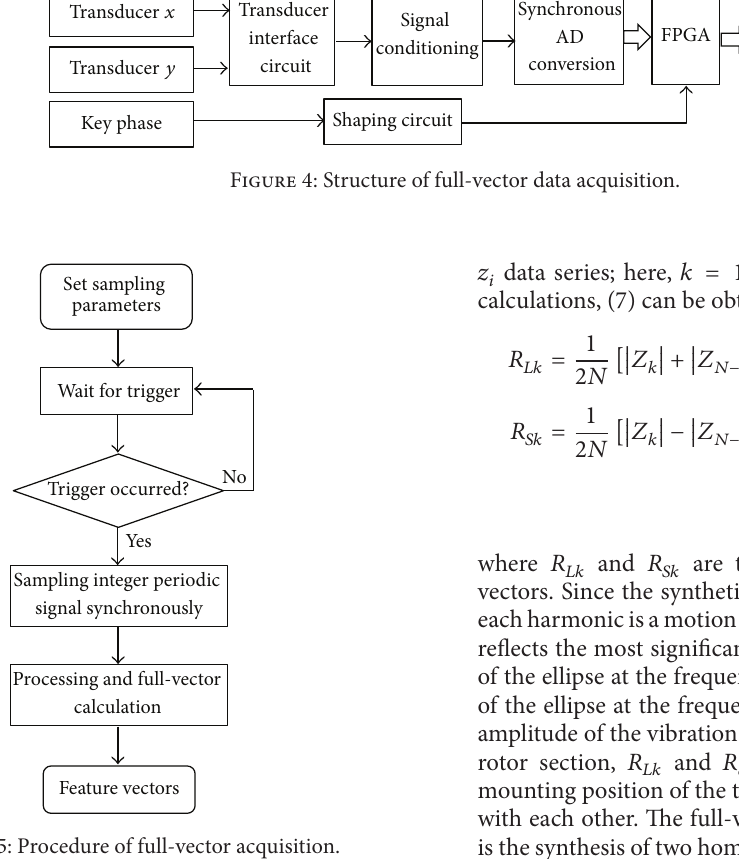
Figure 5: Procedure of full-vector acquisition.